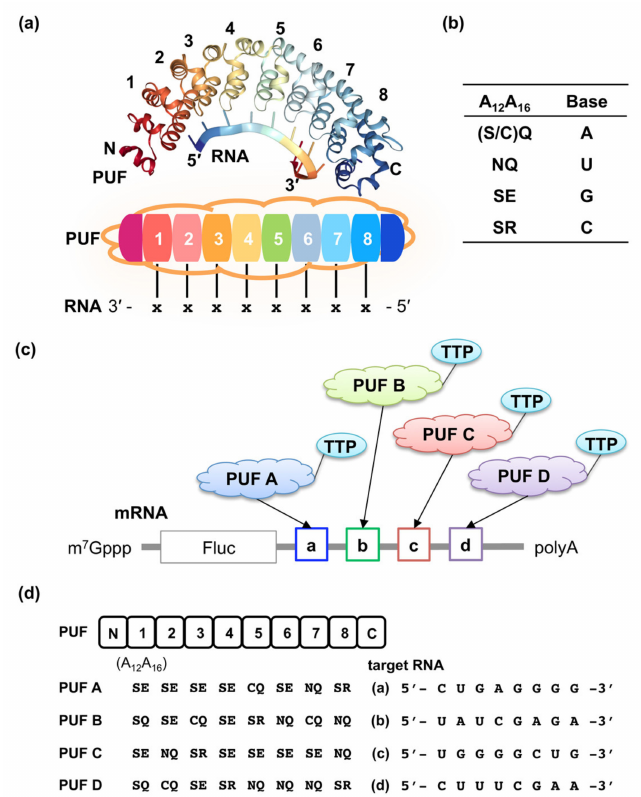
Figure 1. Programmable RNA binding protein, PUF, and regulation of RNA functions. ( a ) Structure of a PUF protein bound to RNA [PDB ID: 1M8Y] and schematic representation of RNA recognition by a PUF protein. ( b ) 12th and 16th amino acids (A 12 and A 16 ) in each PUF repeat interact with an RNA base. ( c ) Schematic representation of mRNA regulation by multiple artificial PUF proteins fused with TTP. ( d ) Design of PUF proteins, PUF (A)–(D), and their recognition RNA sequences, (a)–(d), used in this